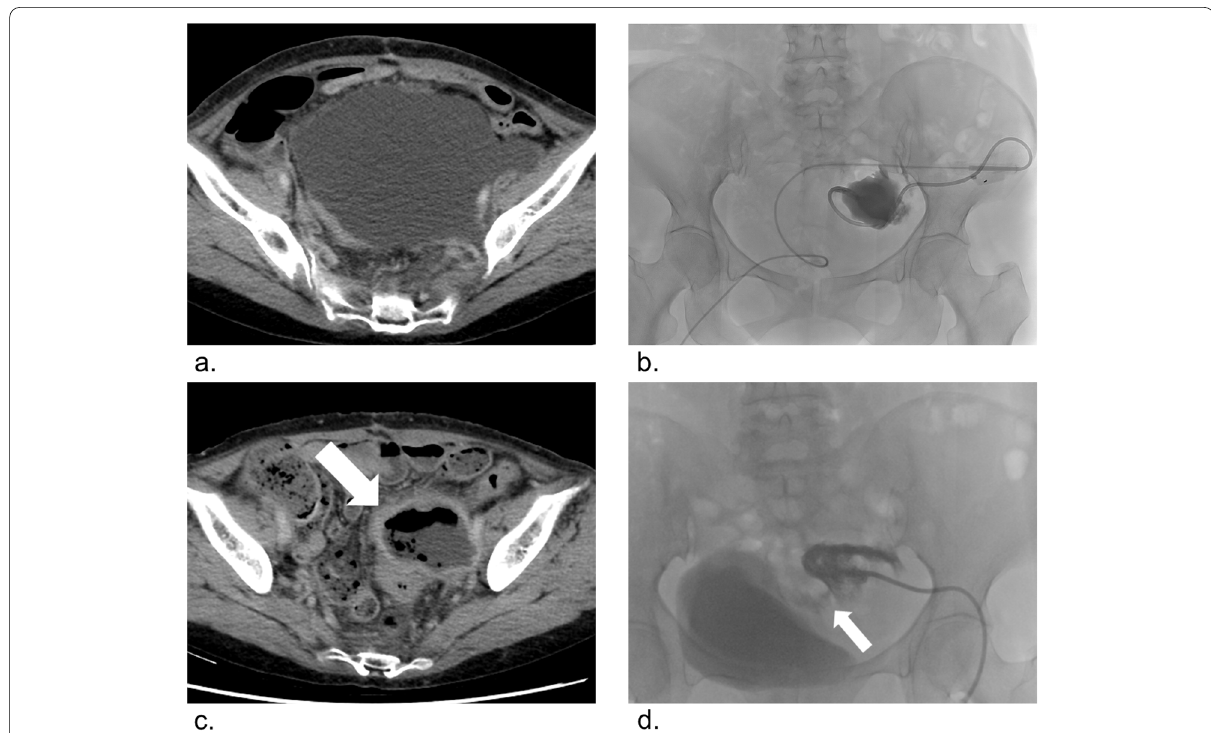
Fig. 3 a Contrast-enhanced computed tomography (CT) after gynecological cancer surgery in a 69-year-old woman presenting with abdominal pain. CT shows pelvic lymphocele. b Cavitogram shows lymphocele reduction, sclerotherapy with OK-432 was performed. c One month after sclerotherapy, CT showed abscess in the pelvic (white arrow). d Cavitogram shows a small bowel fistula (white